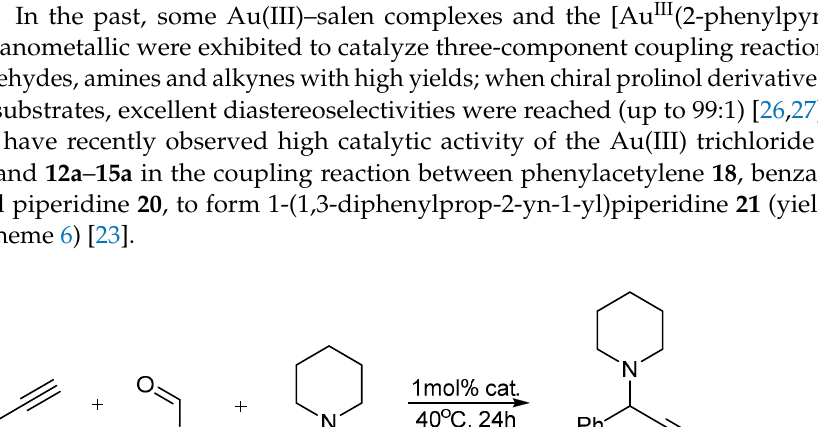
cation C 11 H 8 AuCl 4 NS + (186.0; see Supplementary Data, Figure S22).